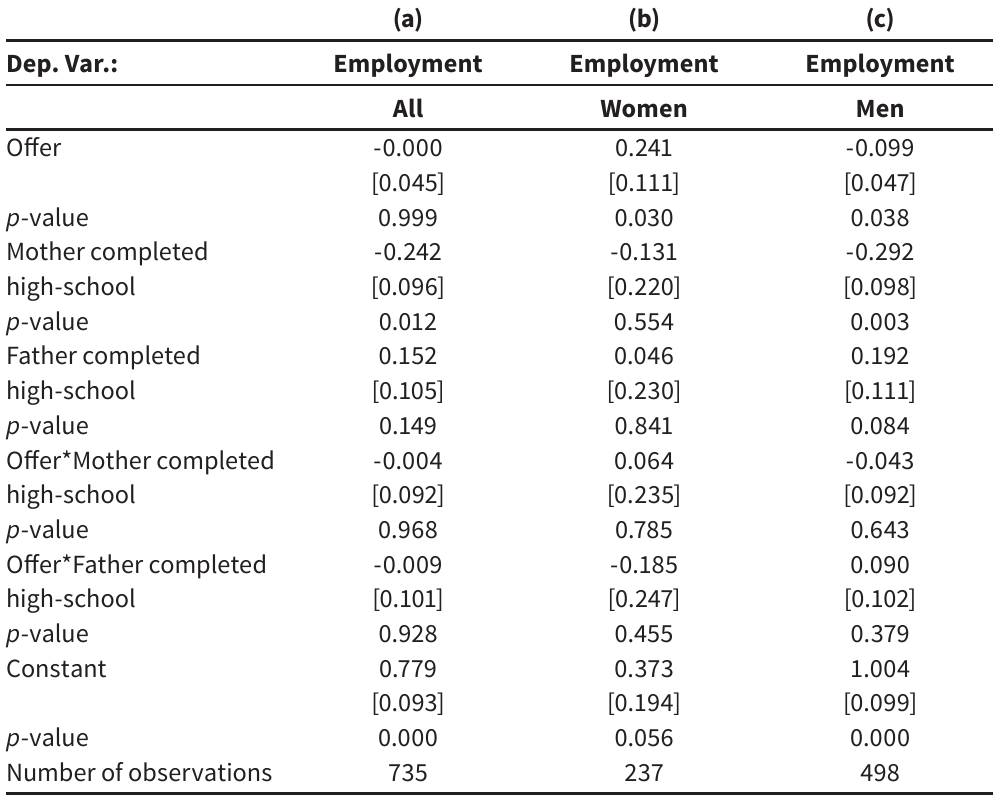
Possible Heterogeneos Effects (a) (b) (c) Dep. Var.: Employment Employment